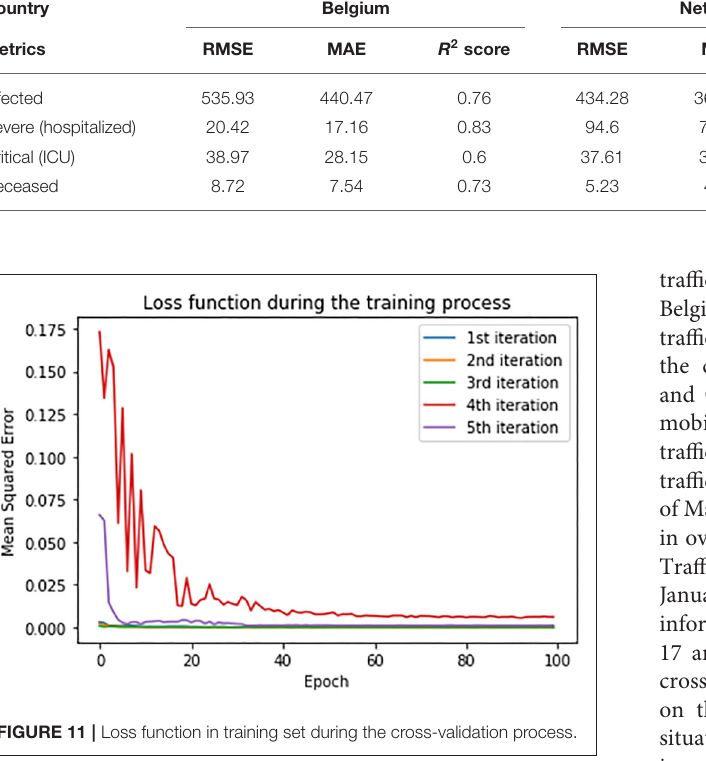
TABLE 5 | The regression metrics on test data of Belgium, Netherlands and Luxembourg using LSTM model. Country